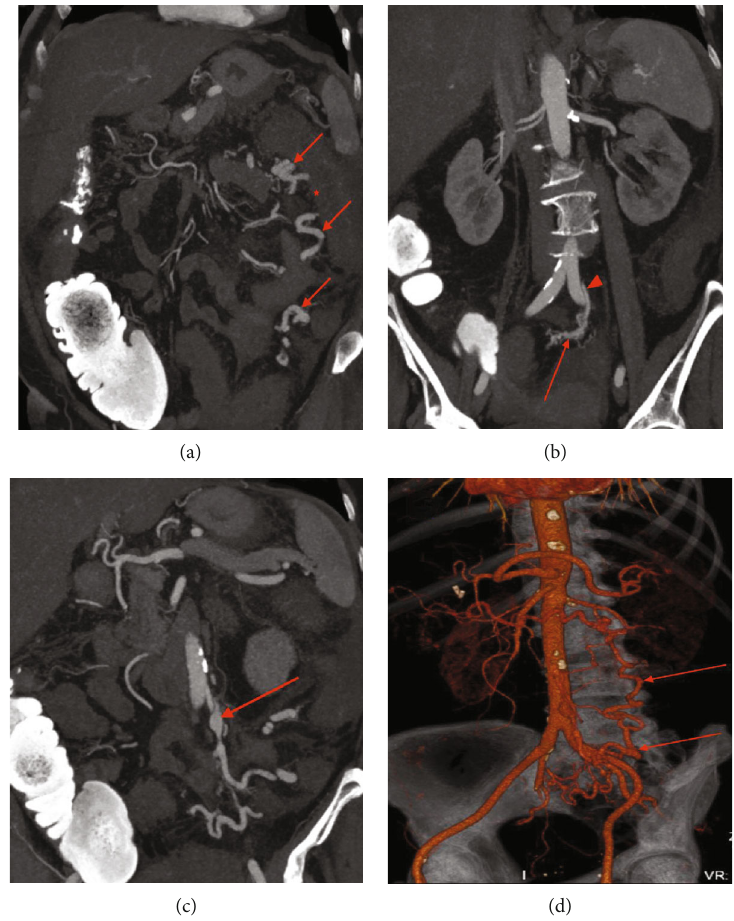
Figure 2: CTA of the abdomen and pelvis (early arterial phase images) 4 days after initial presentation. Maximum intensity projection (MIP) coronal image (a) displays prominent tortuous third-order branches of the IMA within the left abdomen adjacent to the descending colon (arrows). The descending colon appears thickened (star) with persistent pericolonic fat stranding. MIP coronal image (b) displays the superior rectal artery (arrowhead) leading to a tangle of vessels, the presumed nidus (arrow). MIP coronal image (c) exhibits aneurysmal dilatation of a venous out fl ow tract contiguous with out fl ow from the sigmoid territory (arrow). 3D volume rendered coronal oblique image (d) displays the prominent tortuous vascular structure in the inferior mesenteric vascular territory (arrow).